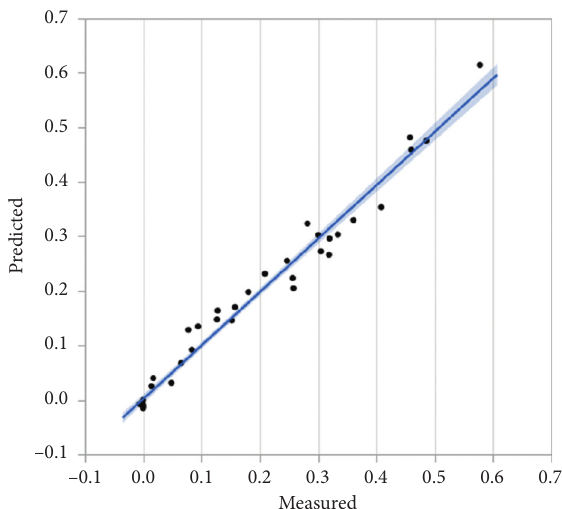
Figure 17: Comparison between coefficient a measured and estimated by (14) and